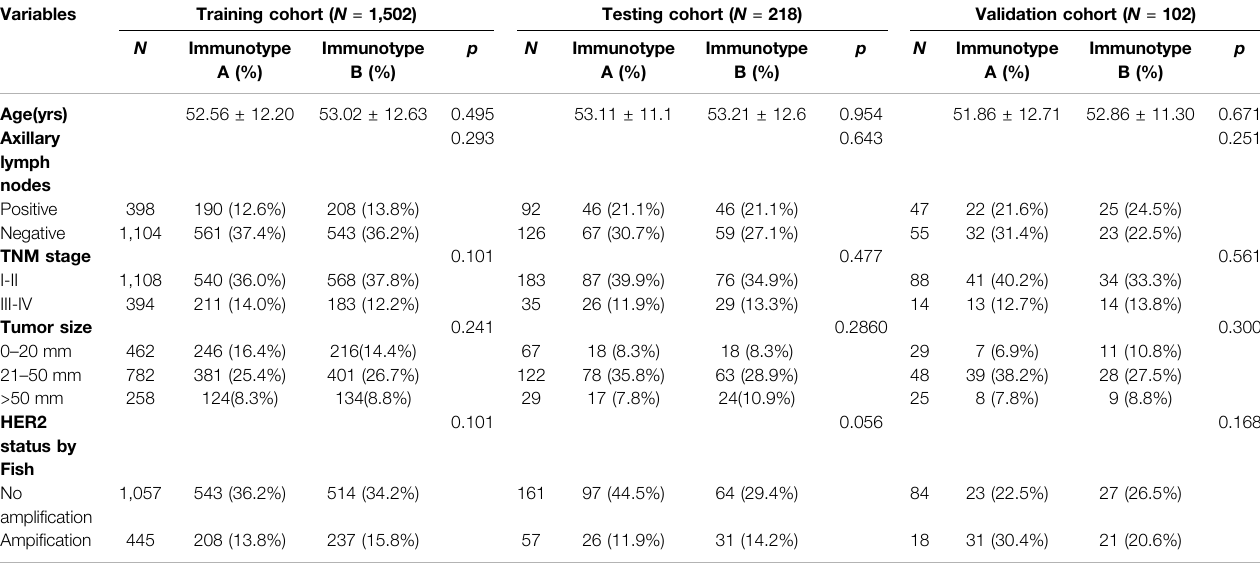
TABLE 1 | Clinical characteristics of patients according to the stromal immunotype in the training, testing and validation